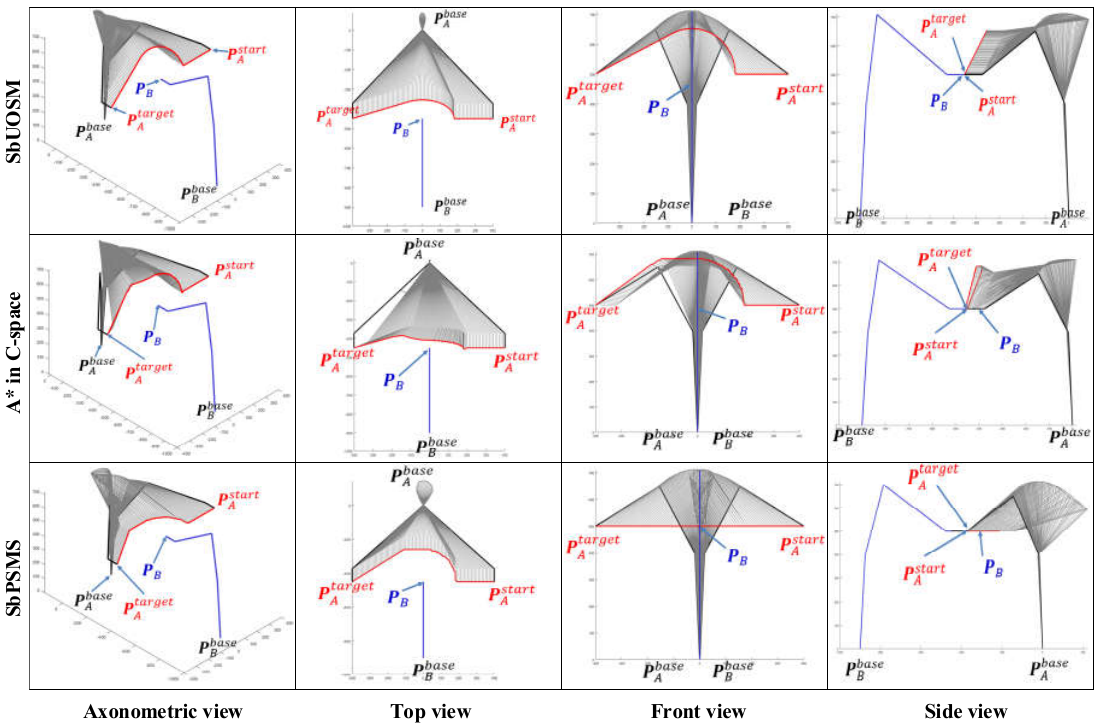
Figure 11. Comparison of simulation results of three path-planning algorithms for Case 5.